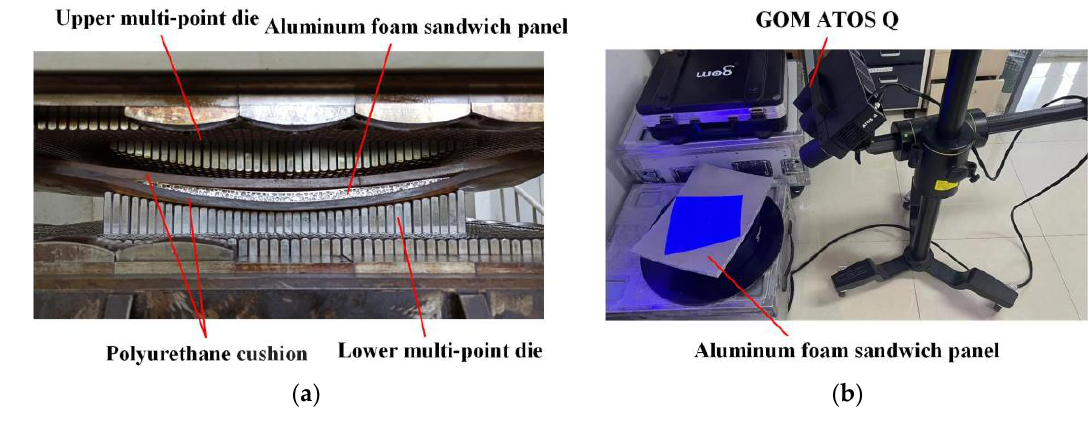
Figure 8. ( a ) MPF of AFSP ( b ) 3D scanning of AFSP.